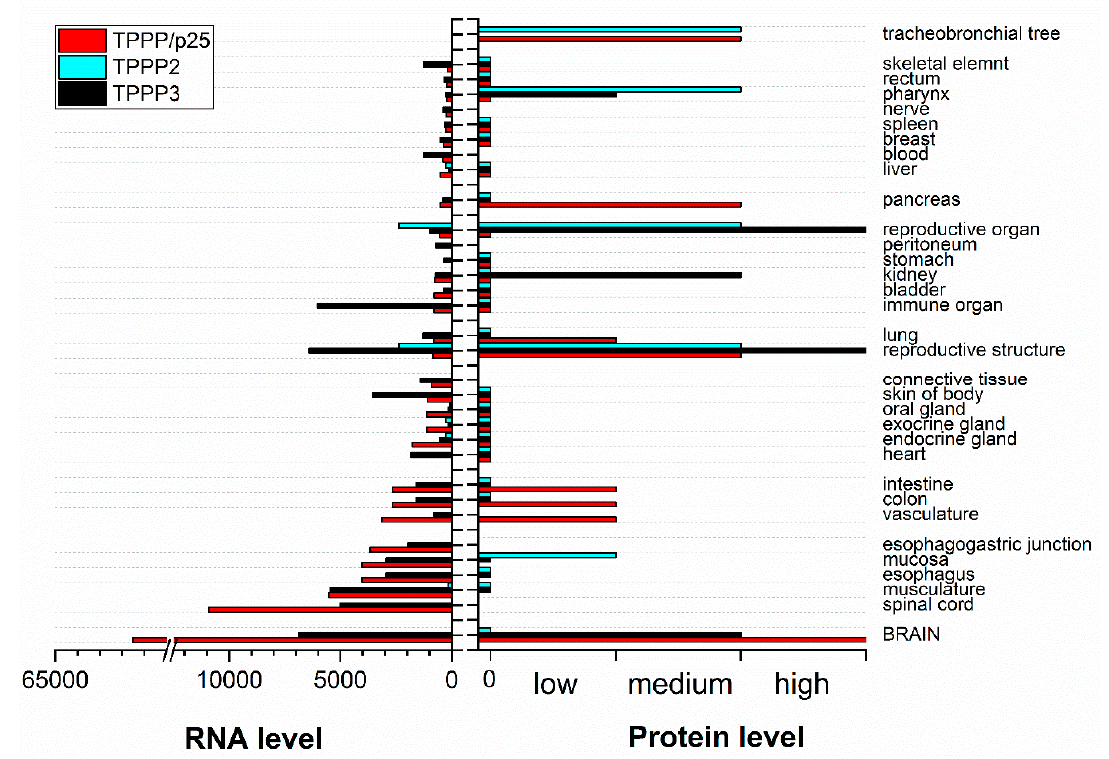
Figure 4. Summary of TPPP RNA and protein baseline expression data in normal human tissues based on RNA-seq expression data, Expression Atlas data and Human Protein Atlas normal tissue immunohistochemistry (https://www.targetvalidation.org) [25]. Columns without value indicate undetermined data.